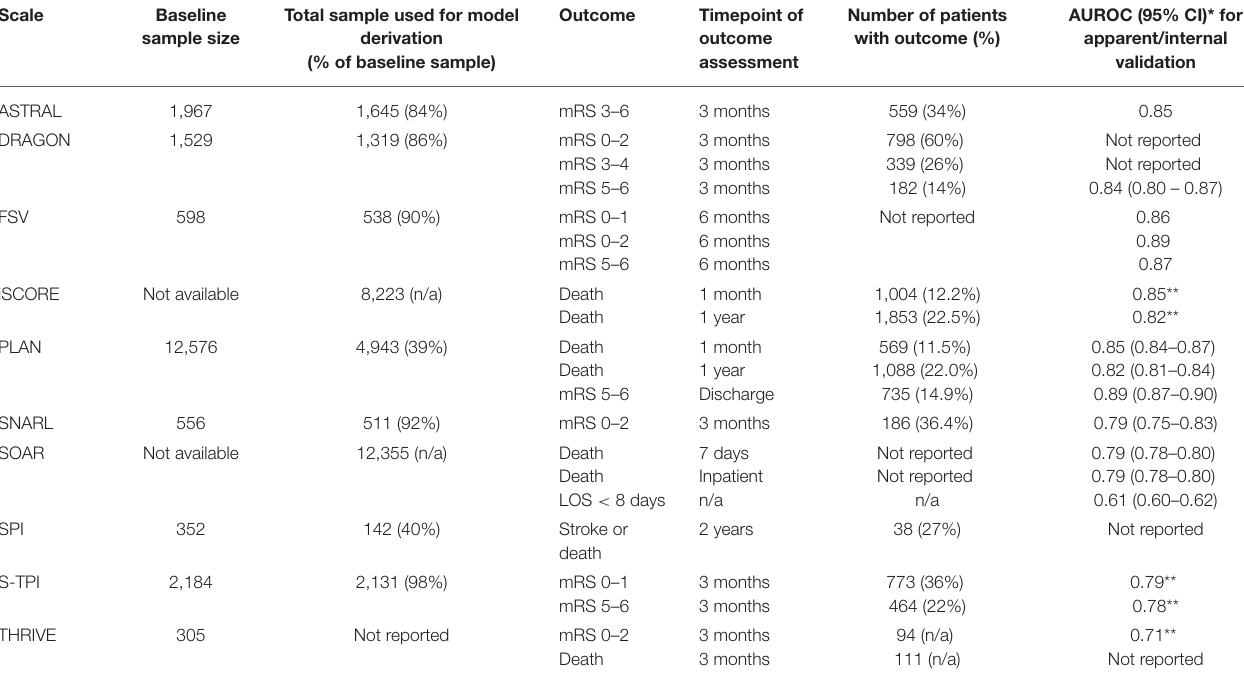
TABLE 2 | Derivation study participants, outcomes and scale discriminatory power.